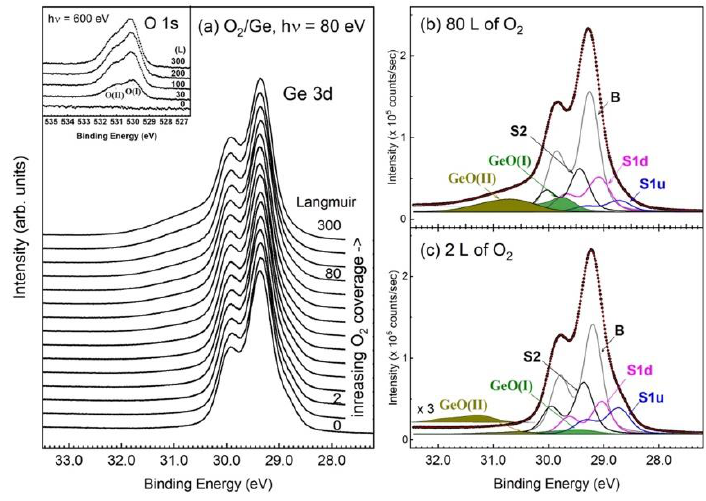
Figure 3. ( a ) The Ge 3d core-level spectra with various dosages of O 2 on an epi Ge(001)-2 × 1 surface at room temperature; ( b ) a fit to the Ge 3d core-level spectrum with 80 L of O 2 on Ge(001)-2 × 1; and, ( c ) a fit to the Ge 3d core-level spectrum with 2L of O 2 on Ge(001)-2 × 1. (Panels ( a ) and ( c ) reprinted with permission from [42], Copyright The Japan Society of Applied Physics, 2018.)